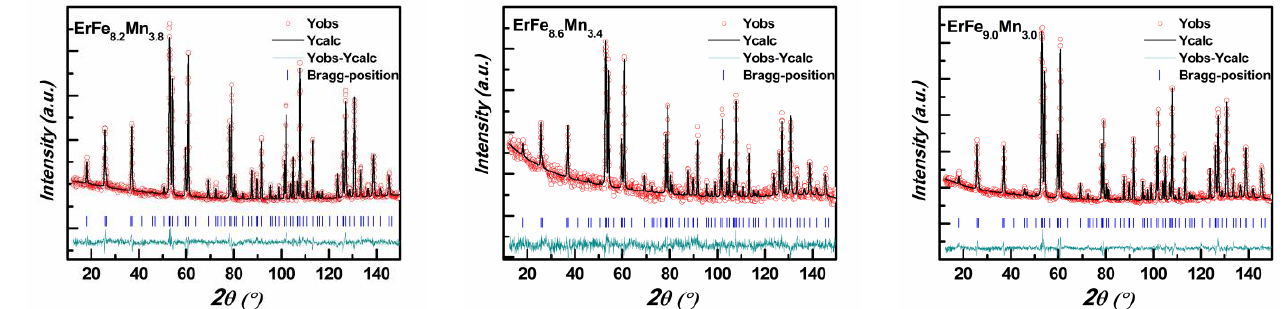
Figure 2. Refined neutron diffraction pattern of ErFe x Mn 12 − x (7.0 ≤ x ≤ 9.0) series alloys (where red dots are experimental data, black curves are theoretical simulations, blue vertical bars are Bragg diffraction peak positions and the bottom green solid line is the difference curve).